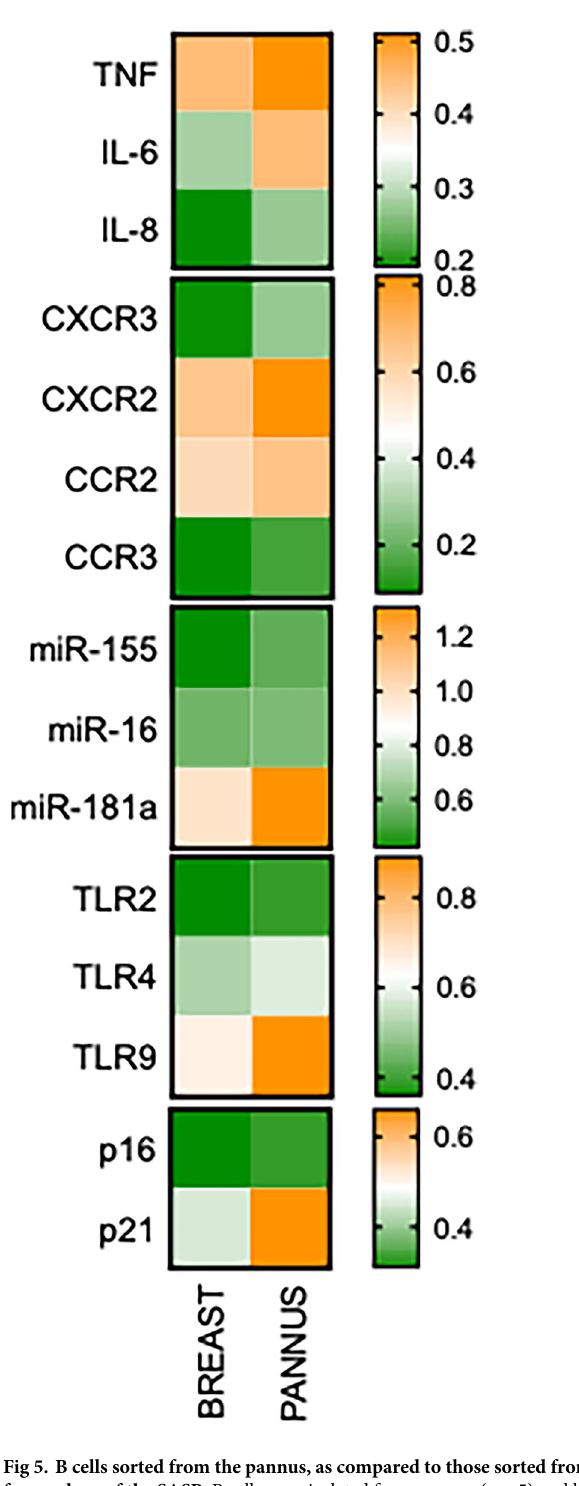
Fig 5. B cells sorted from the pannus, as compared to those sorted from the breast, express higher levels of RNA for markers of the SASP. B cells were isolated from pannus (n = 5) and breast (n = 5) SVFs using flow cytometry and cell sorting. After sorting, B cells were left unstimulated and resuspended in TRIzol. The RNA was then extracted and the expression of SASP markers evaluated by qPCR. Heatmap shows qPCR measures of RNA expression of target genes, relative to the housekeeping genes GAPDH or U6 (for miRs quantification), calculated as 2 - Δ Cts .